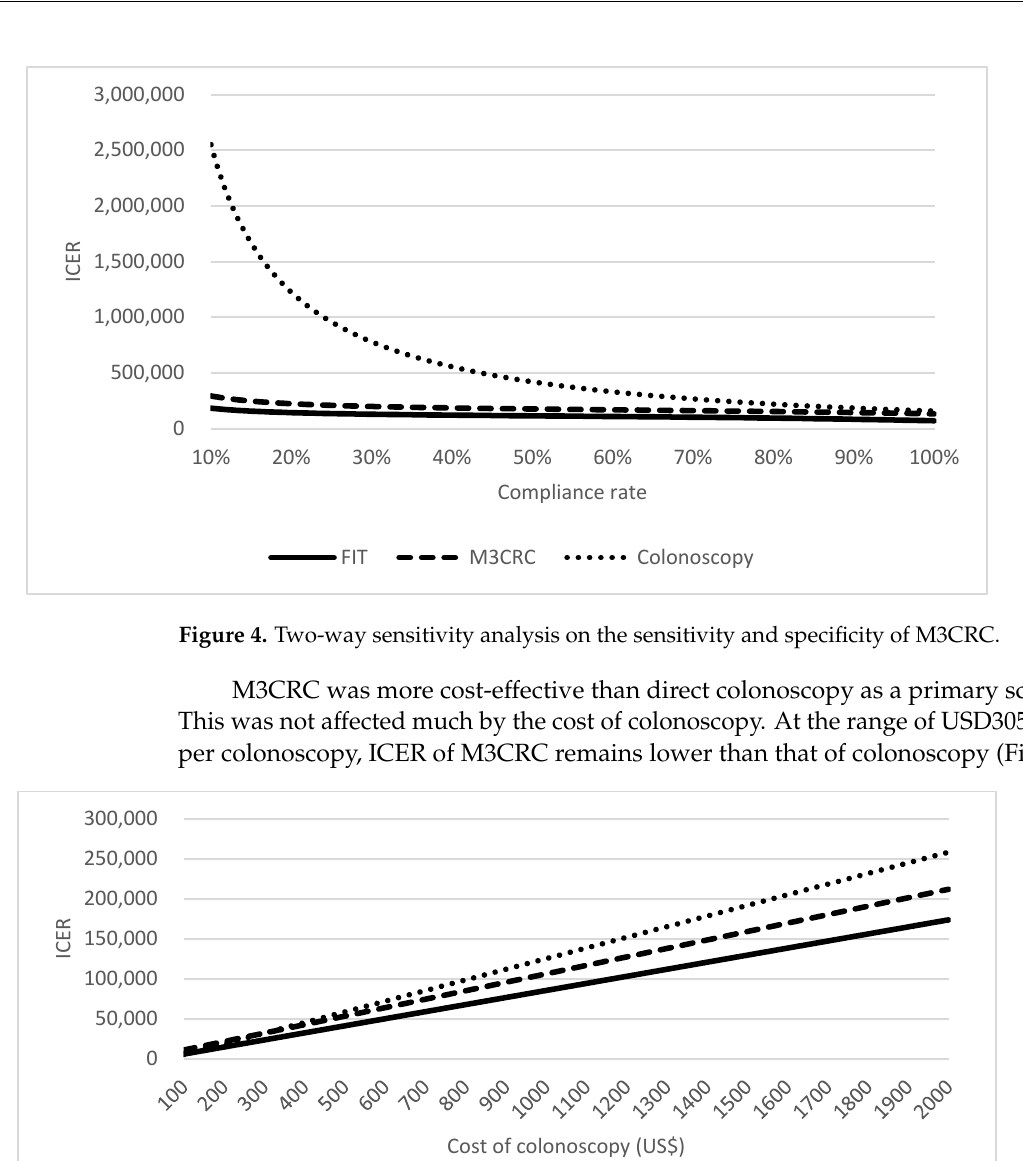
Figure 5. One-way sensitivity analysis on the cost of colonoscopy.